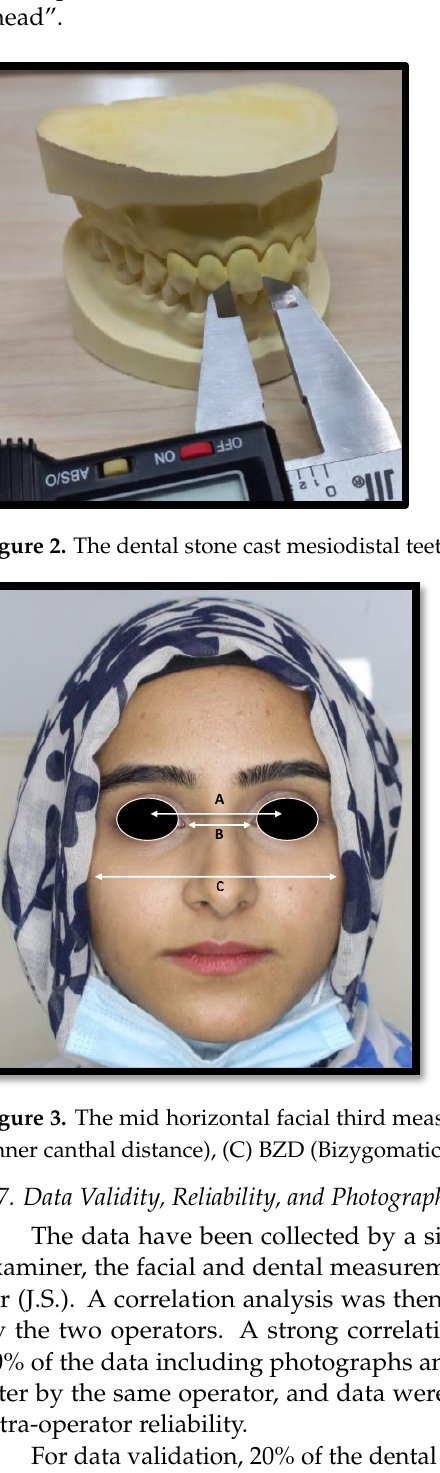
Figure 3. The mid horizontal facial third measurements (A) IPD (Interpupillary distance) (B) ICD (Inner canthal distance), (C) BZD (Bizygomatic distance).